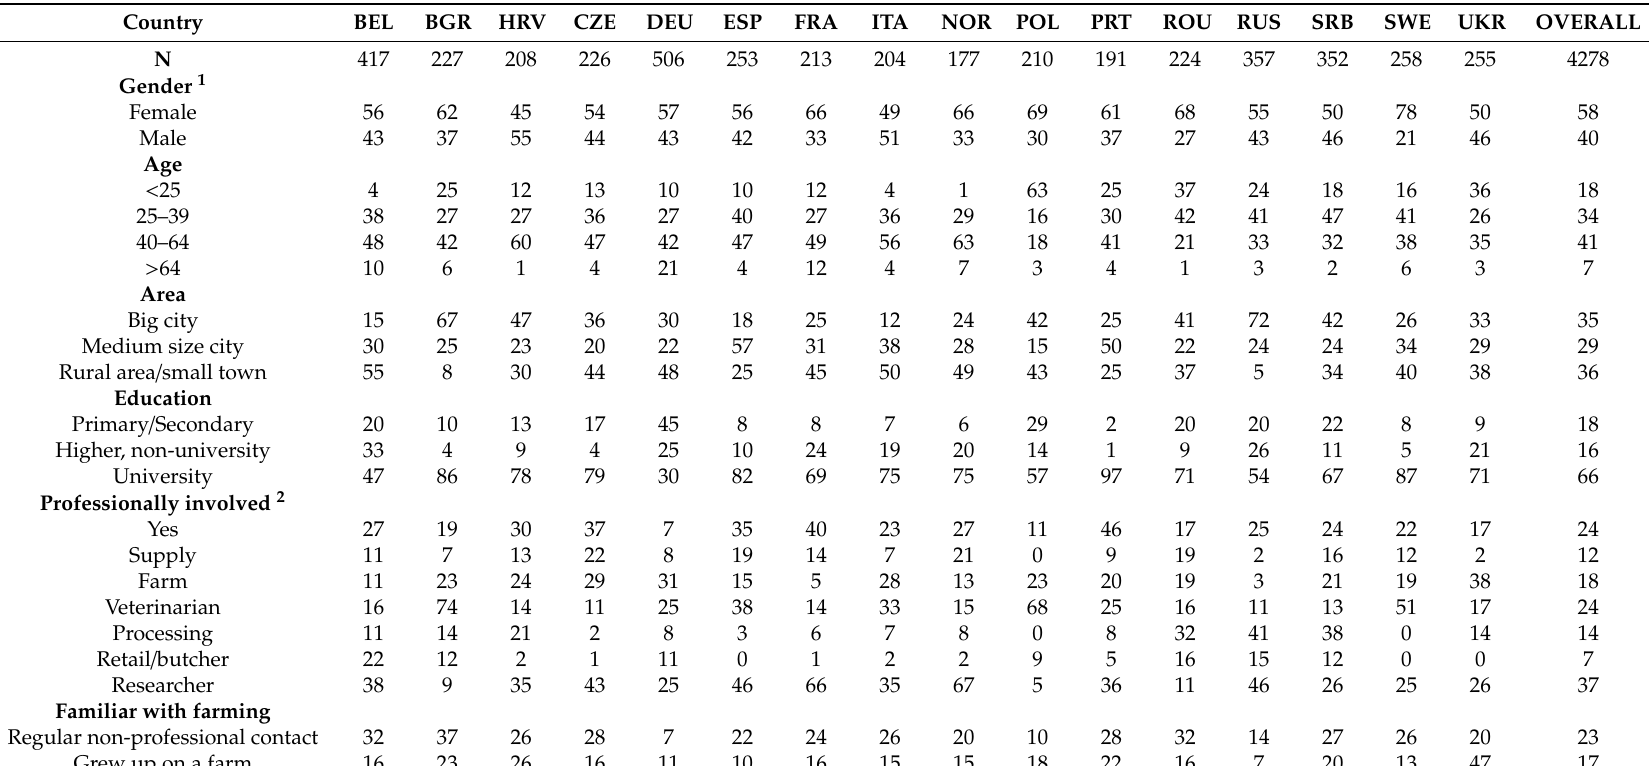
Table 1. Demographic profile of the respondents by country and